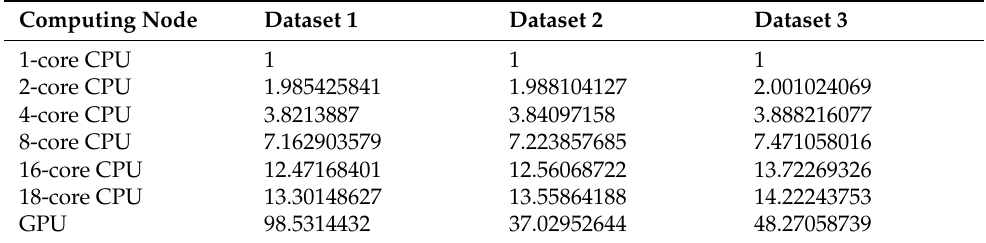
Table 1. Speedup of our proposed parallel multi-set histogram modeling algorithm.